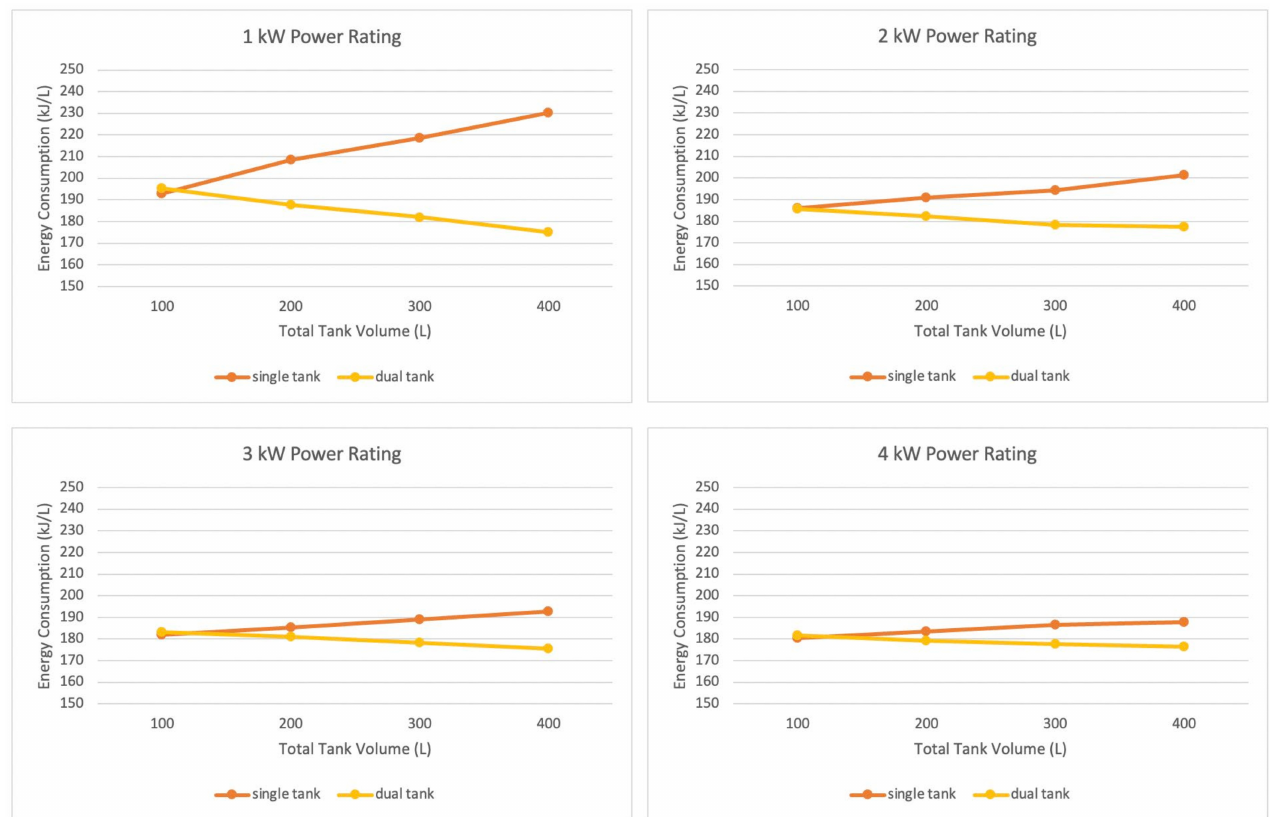
Figure 4. Energy consumption curves per liter of hot water for different power